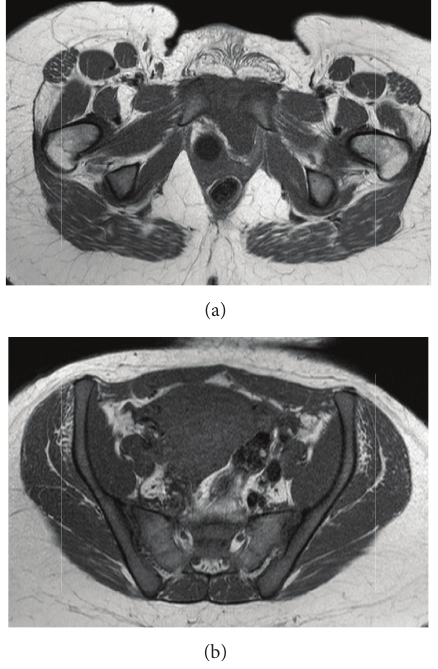
Figure 2: Axial T1-weighted images without contrast are shown in (a) and (b). (a) shows the MRI that confirms the pubic symphysis separation. No separation of the iliosacral joints and no pelvic fracture can be identified in